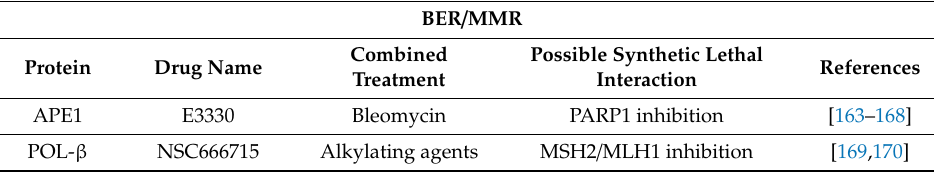
Table 5. BER / MMR-related proteins targeted in cancer